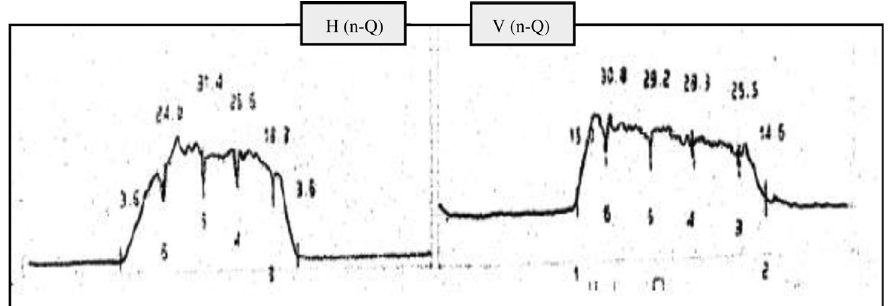
FIG. 13. Transverse Schottky with same markers